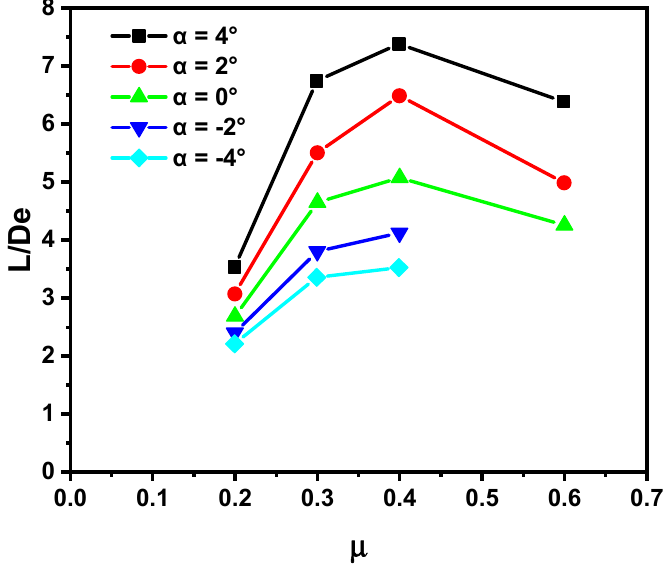
Figure 11. L/De ratio as a function of the advance ratio ( μ ), 1100 rpm. The required power of the coaxial rotor comprises the induced and profile power. It is well known from momentum theory that the induced power decreases as the advance ratio increases, and it is the primary component of the required power in low-speed flight [1]. Therefore, the total power shows a decreasing trend and correspondingly, the L/De ratio increases in the low to moderate advance ratio region. The profile power is required to overcome viscous losses at the rotor, and it scales with the advance ratio as a result of the strengthening of the blade profile drag. When the advance ratio increases to 0.6, the drag and the required power of the coaxial rotor are significantly increased, due to the expansion of the reverse flow region on the retreating side as well as the compressibility effect region on the advancing side, leading to the drop of the L/De